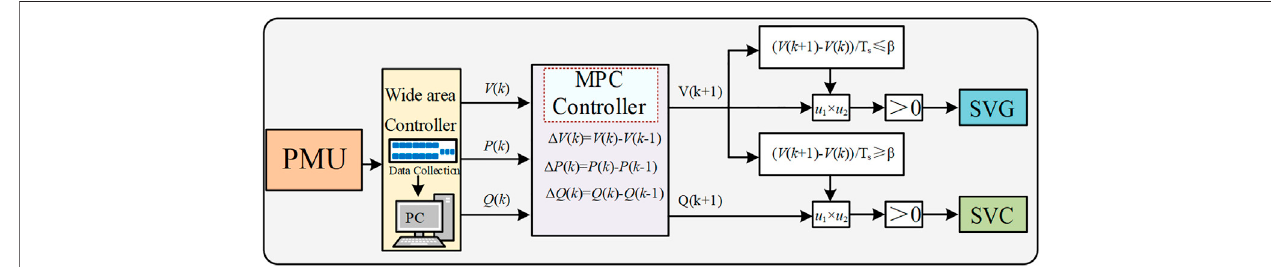
FIGURE 4 | Reactive power voltage optimal control structure based on MPC.